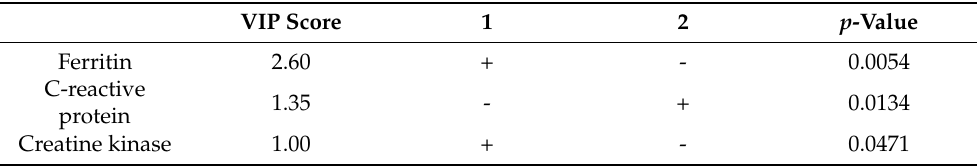
Table 1. VIP score and p -value calculated (calculated by MetaboAnalyst.R) for clinical parameters of fibromyalgia patients suffering from moderate depression (1) or severe depression (2). VIP Score 1 2 p -Value Ferritin 2.60 + - 0.0054 C-reactive 1.35 - + 0.0134 protein Creatine kinase 1.00 + -